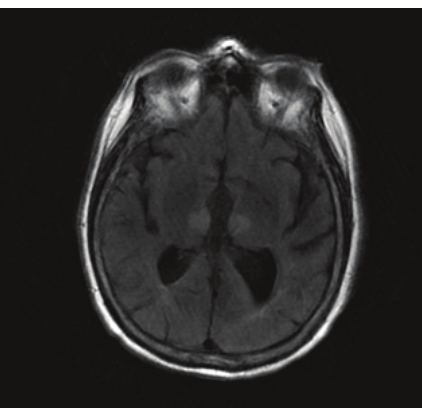
Figure 1: MRI with fast fluid-attenuated inversion showing hyper- intensity at bilateral thalamic